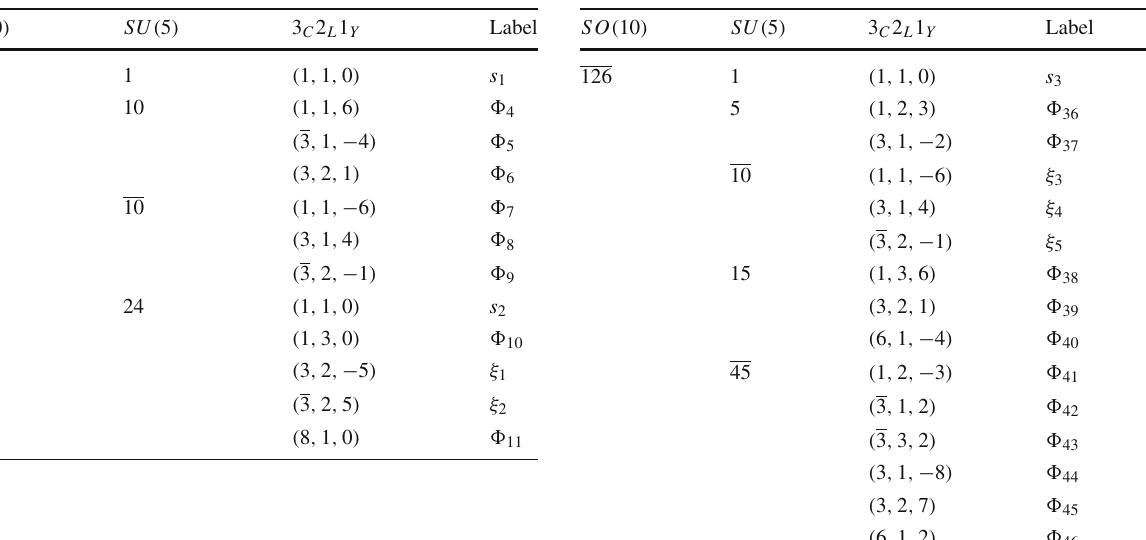
Table 3 Decomposition of the scalar 45 representation of SO ( 10 ) with respect to the subgroups SU ( 5 ) and SU ( 3 ) C × SU ( 2 ) L × U ( 1 ) Y . For further details, see Table 1